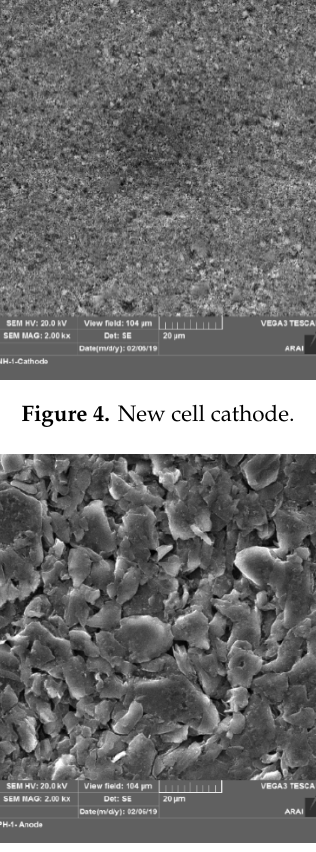
Figure 5. Nail-penetrated cell anode with location away from centre (50% state of charge (SoC)).